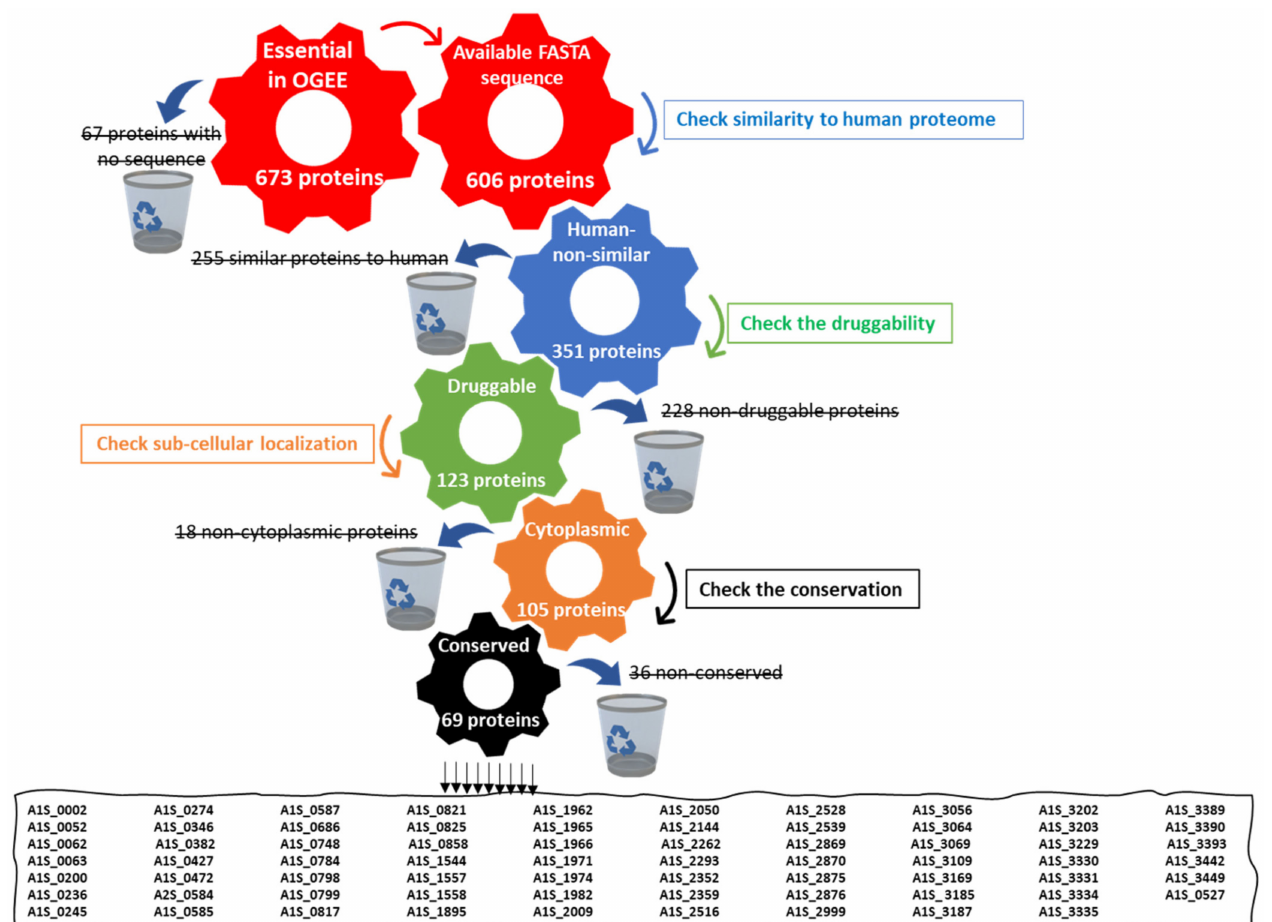
Figure 1. A diagram showing the systemic workflow of drug target identification using a subtractive proteomics approach. The analysis involves passing five channels, using a different tool in each one. The first channel includes the retrieval of essential proteins from the Online GEne Essentiality (OGEE) database. The second one involves checking their homology with a human host. The third channel involves checking their druggability using DrugBank. The fourth one involves the sub-cellular localization of target proteins using PSORTb then CELLO tools. The fifth channel involves checking the conservation of the target proteins in all available Acinetobacter baumannii strains using the NCBI BLASTp tool. Finally, the figure shows the 69 shortlisted target proteins with their code in OGEE. The black horizontal lines mean “excluded